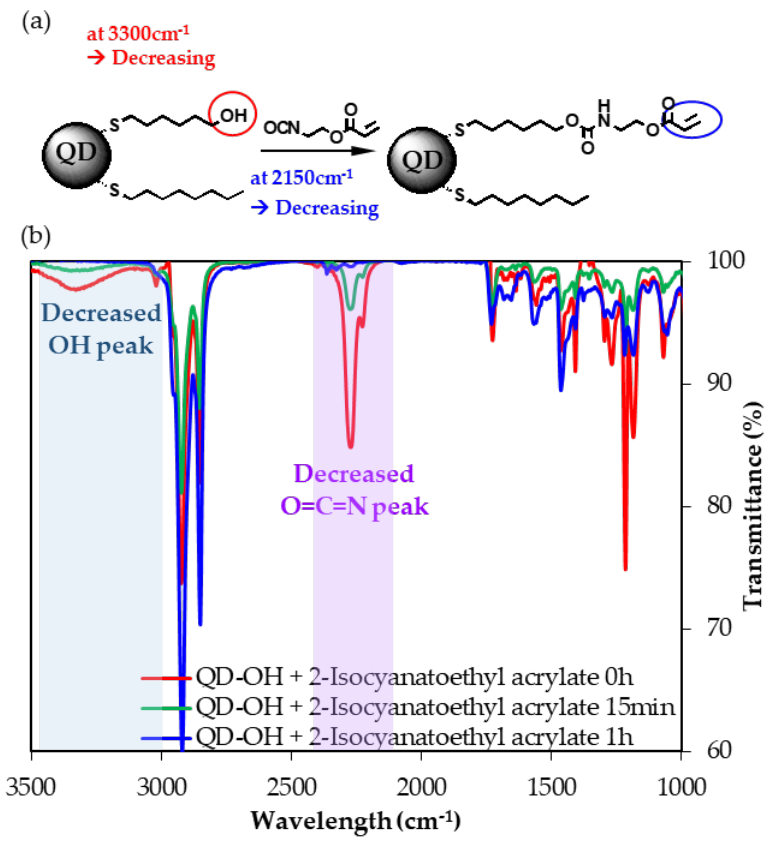
Figure 1. ( a ) The reaction scheme. ( b ) The reaction tracing by FT-IR. As the reaction progressed, the alcohol peak at 3300 cm − 1 and the isocyanate peak at 2250 cm − 1 progressively diminished in